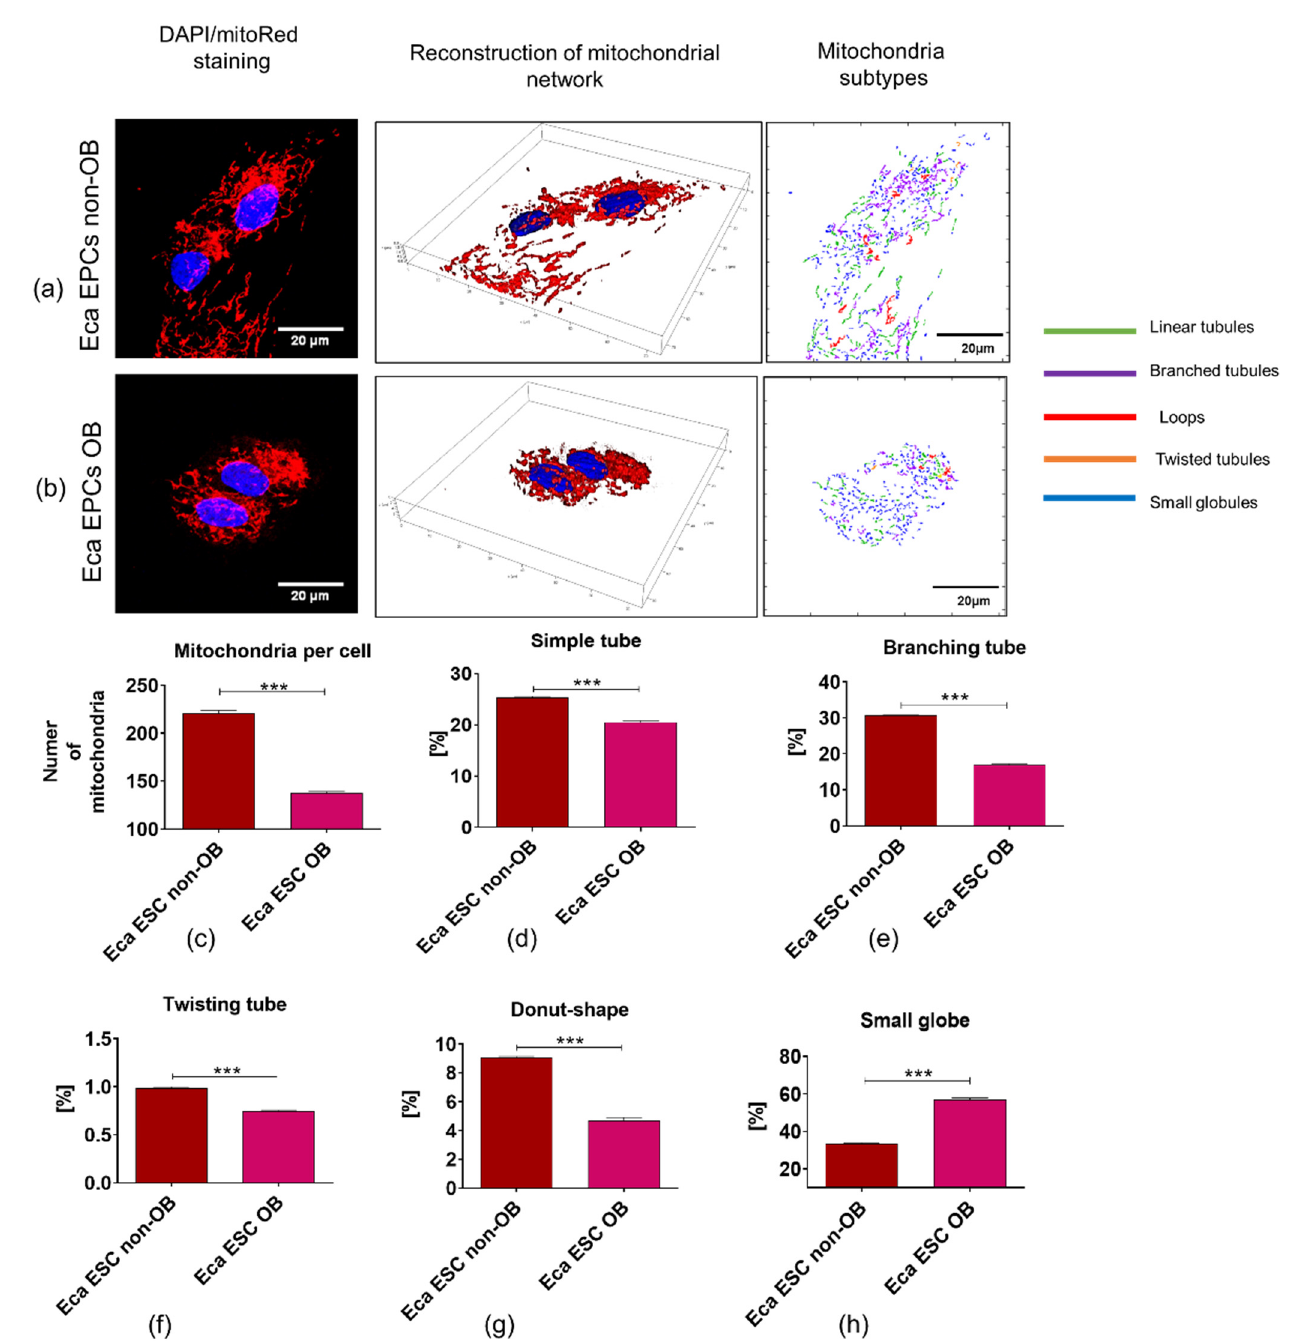
Figure 6. Mitochondrial network, numbers, and morphology of equine endometrial progenitor cells (Eca EPCs) isolated from non-obese mares (non-OB) and obese mares (OB). Imaging of Eca EPCs with high magnification allowed assessment of the mitochondrial net and its dynamics ( a , b ), the number of mitochondria per cell ( c ) and classification of mitochondrial morphology ( d – h ). Mean ± SD is presented as columns and bars. *** p -value < 0.001.